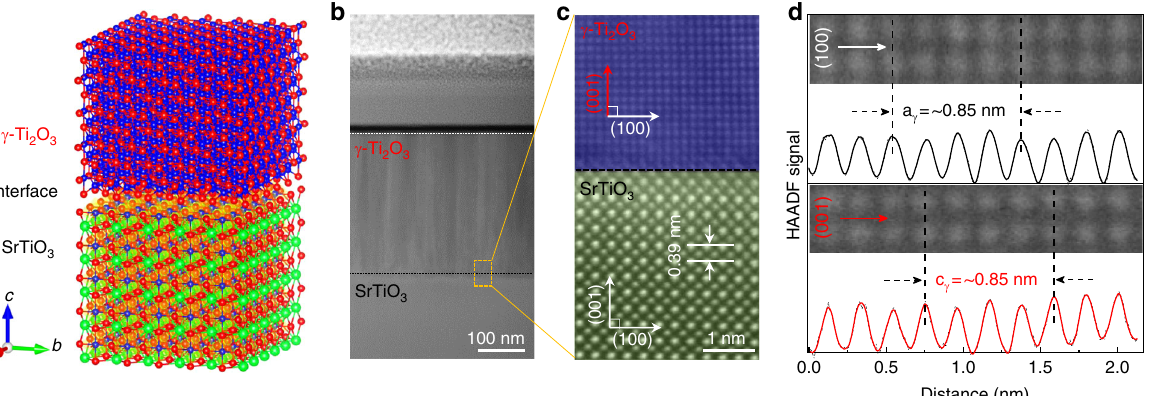
Fig. 2 Microstructural characterization of the cubic γ -Ti 2 O 3 polymorph. a Sketch of the γ -Ti 2 O 3 /STO heterostructure. b Cross-sectional low-resolution STEM image and ( c ) high-resolution HAADF-STEM image of the γ -Ti 2 O 3 /STO interface. d HAADF-STEM image and the corresponding HAADF signal pro fi le obtained along (100) and (001) directions of γ -Ti 2 O 3 from ( c )